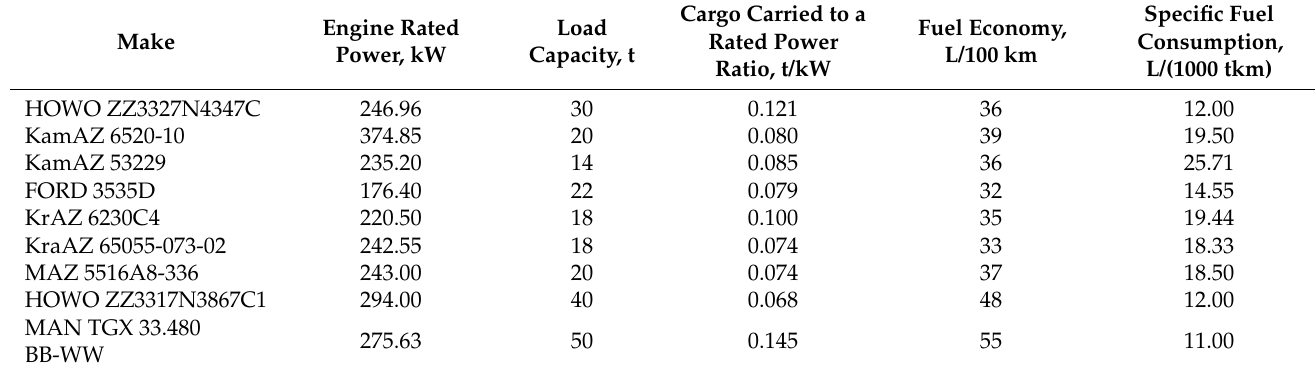
Table 3. Characteristics of selected trucks (road grain carriers).